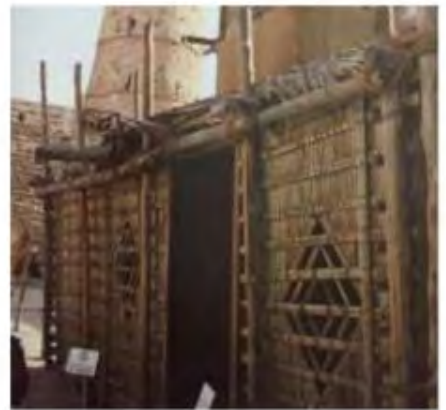
Figure 5. Date Palm Rachis Walls in Arish House (Piesik, 2012)